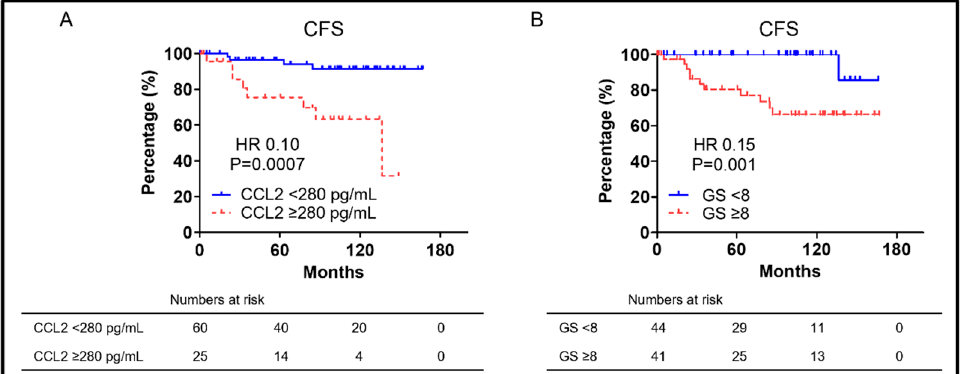
Figure 3. ( A ) Kaplan–Meier curves of CFS in nmCSPC with CCL2 ≥ 280 pg/mL and CCL2 < 280 pg/mL. ( B ) Kaplan–Meier curves of CFS in nmCSPC with GS ≥ 8 and GS < 8. Numbers at risk for each group are shown at the bottom of the figure. CFS, castration-resistant prostate-cancer-free survival; GS, Gleason score; HR, hazard ratio; and nmCSPC, non-metastatic castration-sensitive pros- tate cancer.